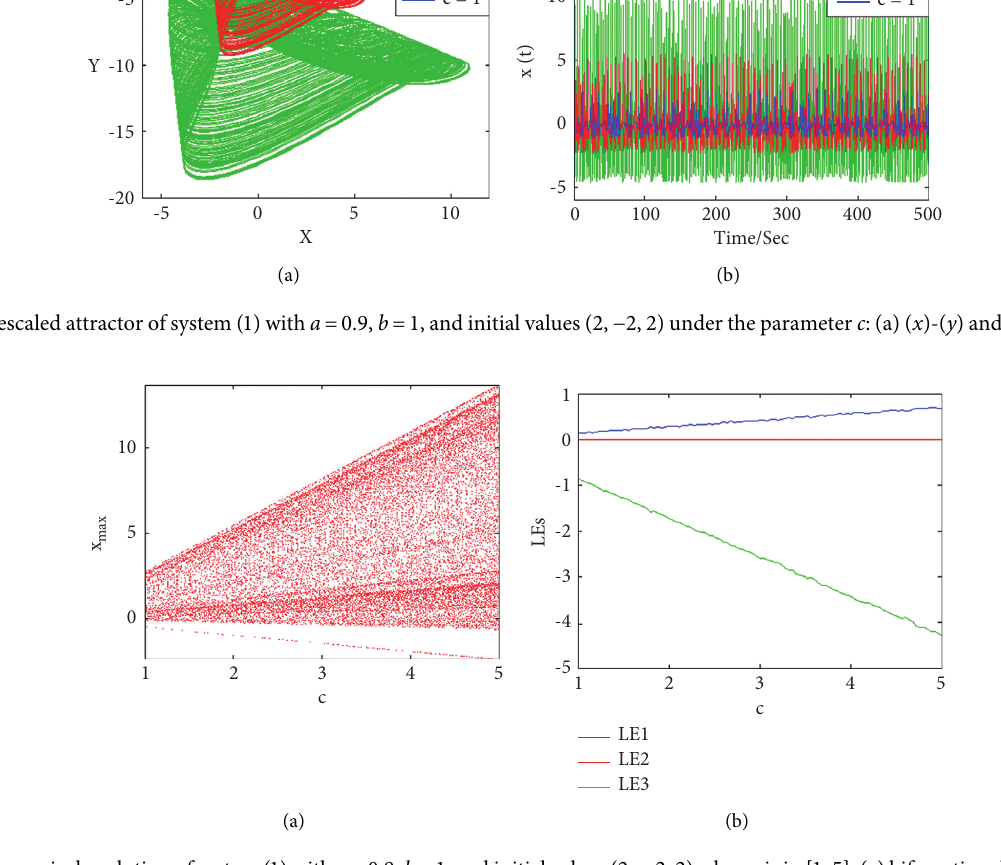
Figure 3: Dynamical evolution of system (1) with a � 0.9, b � 1, and initial values (2, − 2, 2) when c is in [1, 5]: (a) bifurcation diagram and (b) Lyapunov